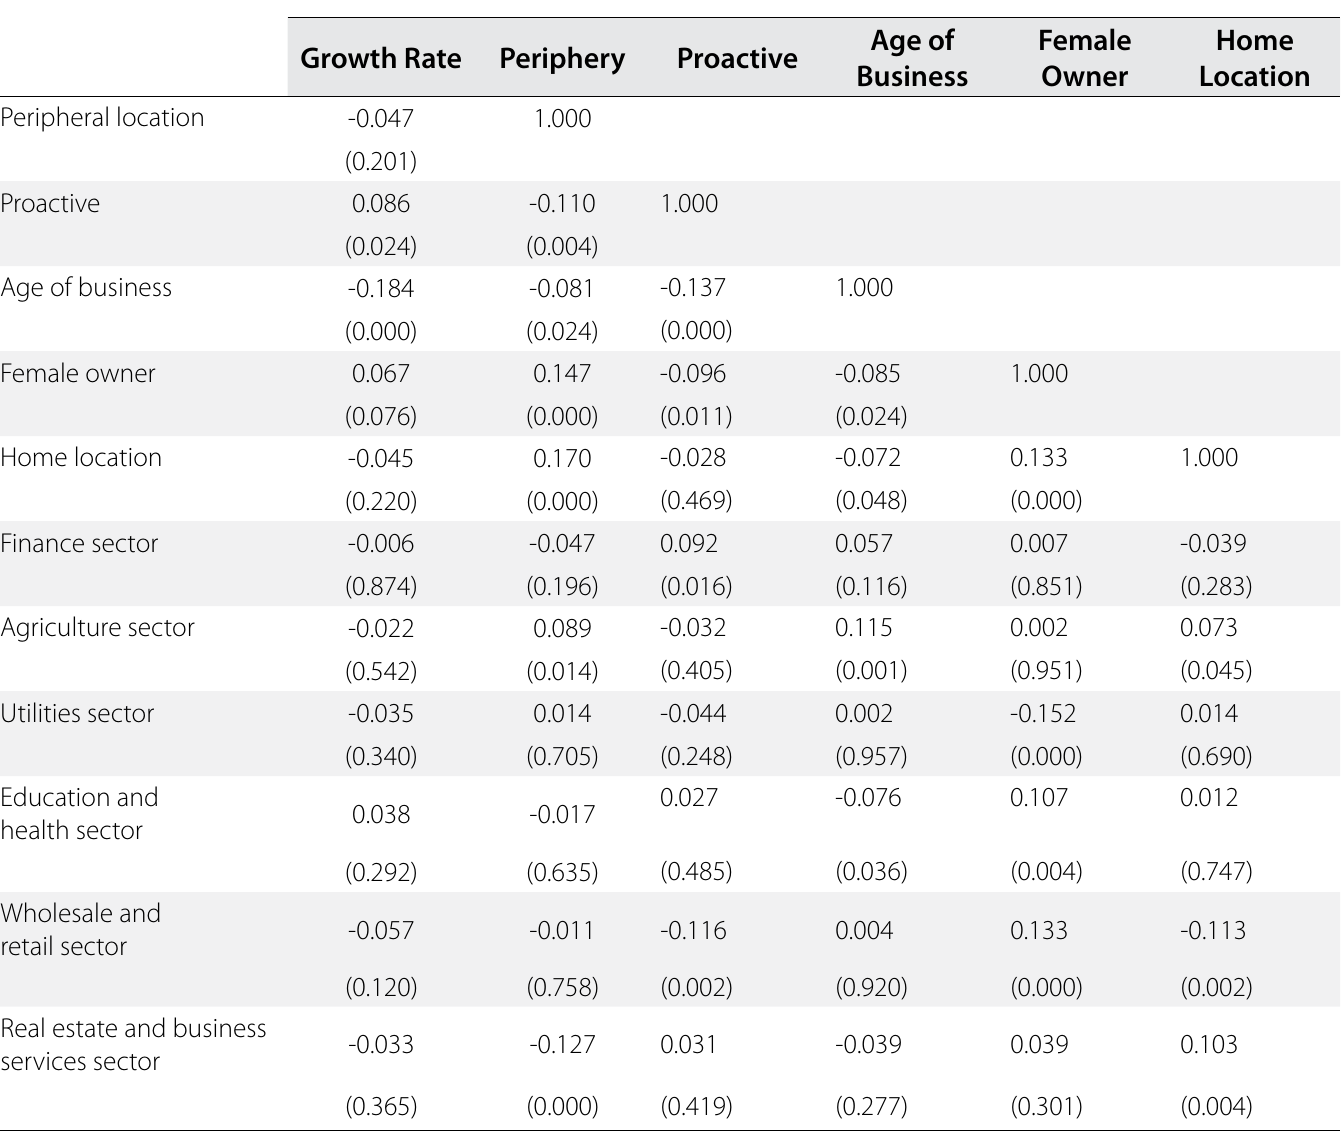
Table 2: Correlations between Variables (n=626; p-values in